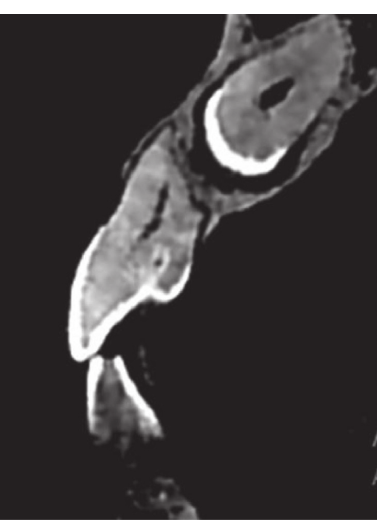
Figure 2: Example of coronal invagination of the left maxillary lateral incisor associated with an impacted maxillary canine (cross- sectional